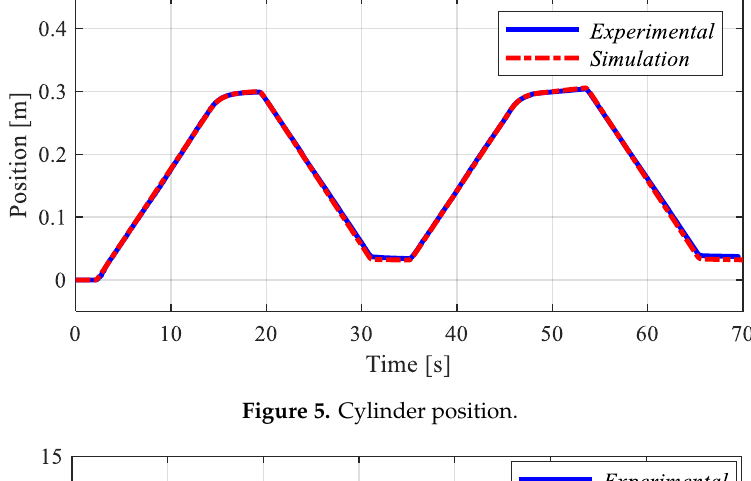
Figure 5. Cylinder position.